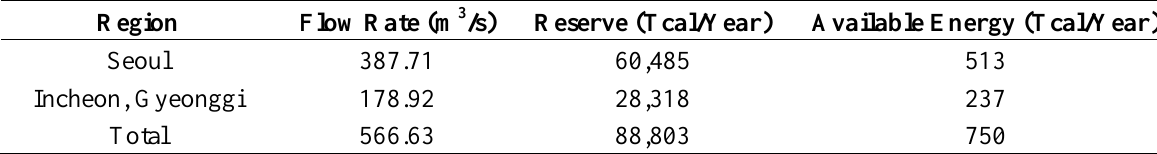
Table 5. River water energy reserve and available energy in each region.